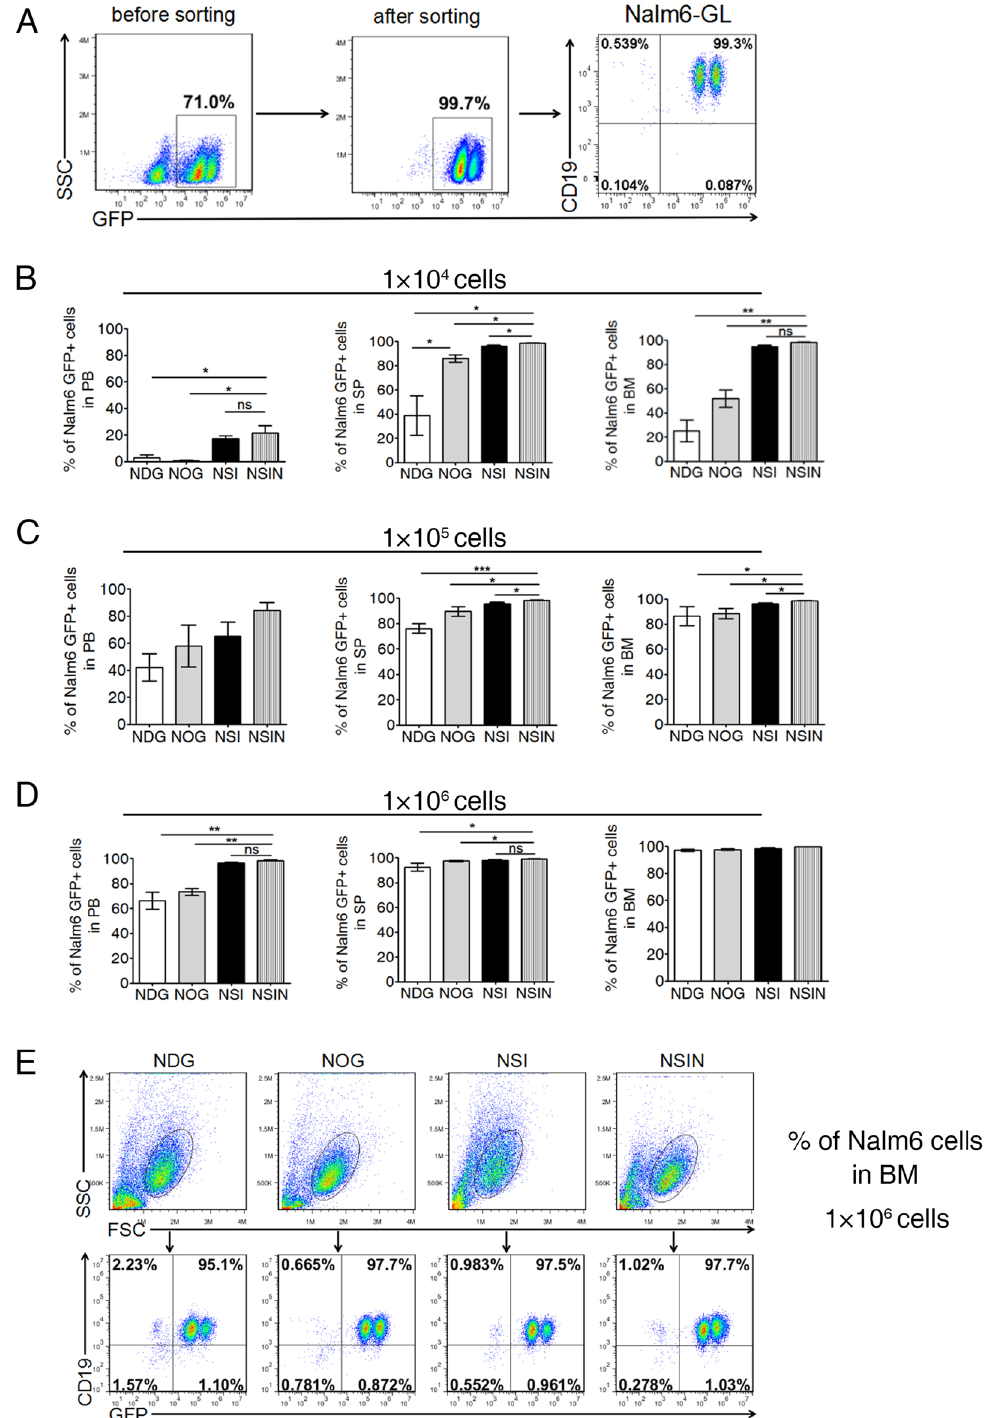
Figure 4. Engraftment efficiencies of Nalm6-GL cells in NDG, NOG, NSI, and NSIN mice. ( A ) Establishment of the Nalm6-GL cell line. Nalm6 cells were transfected with luciferase-GFP-expressing lentiviral vectors and sorted on GFP + cells. Nalm6-GL cells were labeled for human CD19 + and GFP + . ( B – D ) Percentages of Nalm6-GL cells in the PB, SP, and BM of NDG, NOG, NSI, and NSIN mice injected with ( B ) low (1 × 10 4 , n = 5 for each strain), ( C ) medium (1 × 10 5 , n = 5 for each strain), and ( D ) high numbers (1 × 10 6 , n = 5 for each strain) of Nalm6-GL cells. Nalm6-GL cells were injected into each mouse through the tail vein and analyzed on day 20, 24, or 32 for the low-, medium-, and high-dose groups, respectively. ( E ) Engraftment efficiencies of Nalm6-GL cells were further confirmed by labeling with human CD19 + in the BM from the high-dose (1 × 10 6 ) group. Cells were gated from FSC/SSC. Error bars denote the standard error of the mean (SEM). Groups were compared using a two-tailed unpaired t -test. * P < 0.05; ** P < 0.01; *** P <